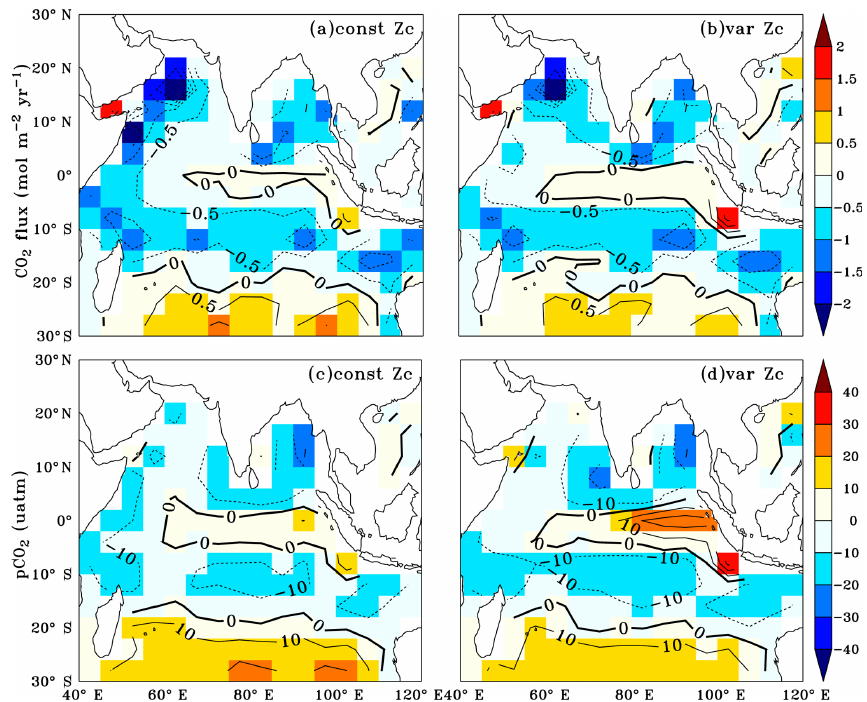
Figure 4. Annual mean biases in the model evaluated against Takahashi et al. (2009) observations for CO 2 flux (a, b) and p CO 2 (c, d) with constant Zc (const Zc ) and varying Zc (var Zc ). Units of CO 2 flux and p CO 2 are molm − 2 yr − 1 and µatm,